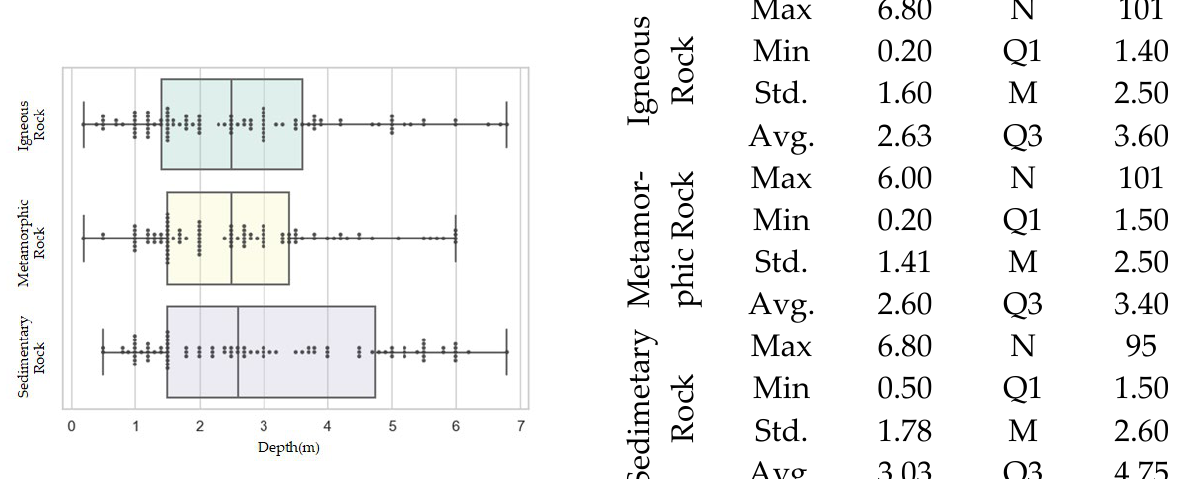
Figure 2. Descriptive statistics on three representative rock types sampled in the study area (Gangwon